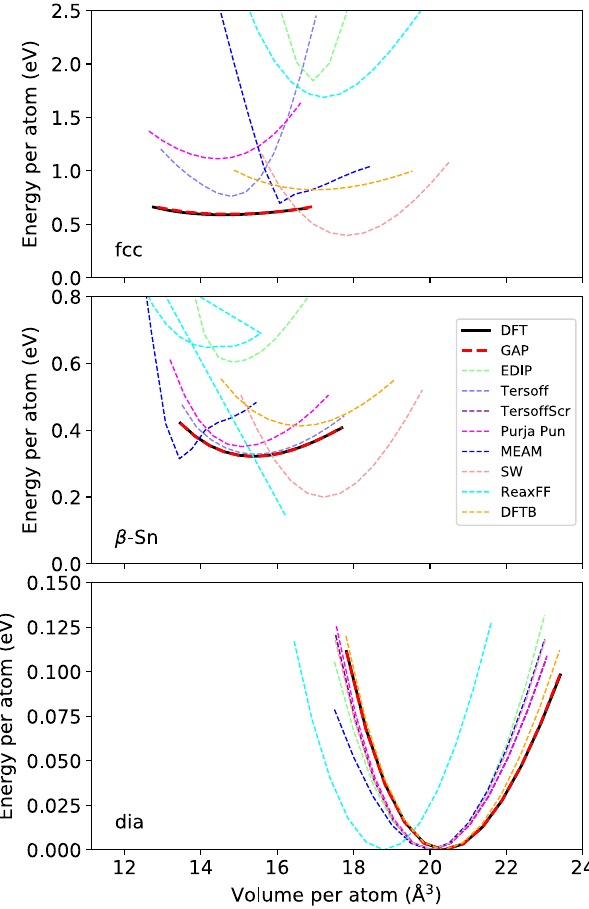
FIG. 5. Energy per atom vs volume per atom for various bulk crystal lattice structures computed using the DFT (solid lines) and GAP (dashed lines). The hcp 0 structure (indicated by an arrow), which is not in the fitting database, has a substantially larger discrepancy between the DFT and GAP than any of the other structures, all of which are in the database.